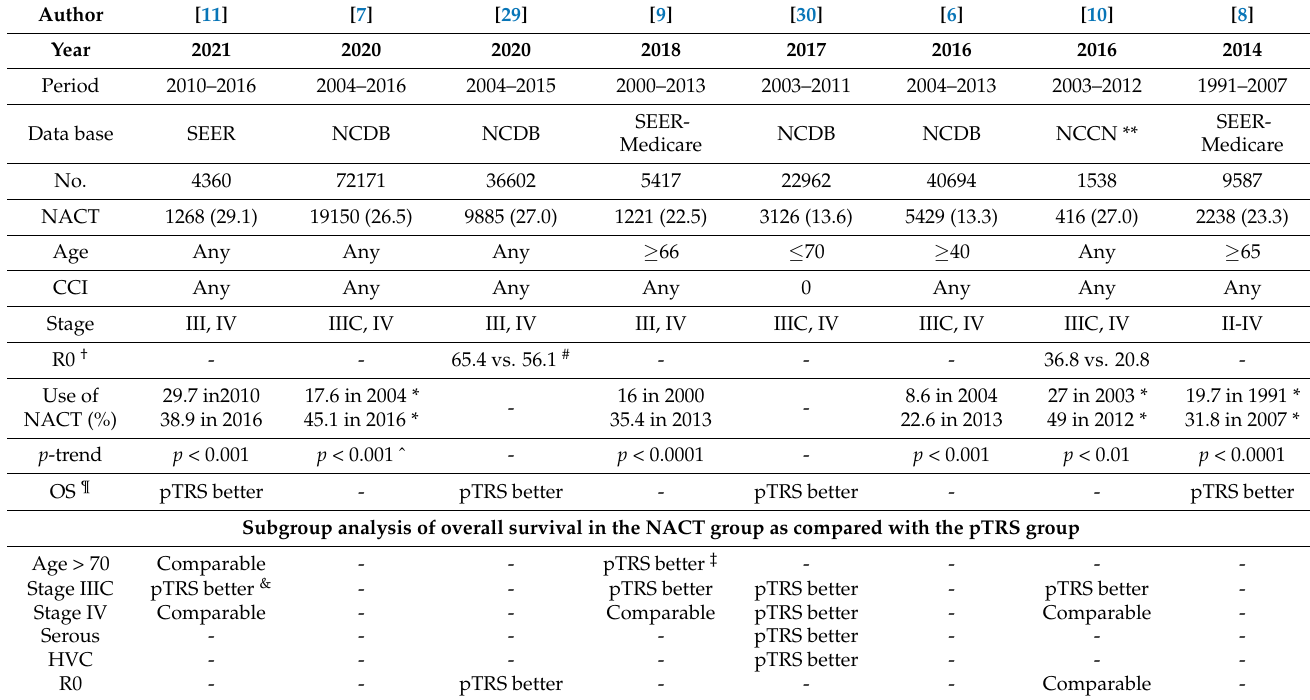
Table 2. Summary of population-based studies comparing NACT to pTRS in advanced epithelial ovarian